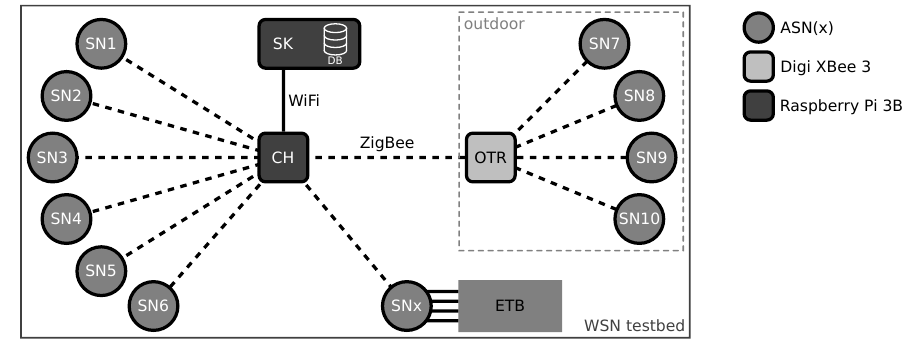
Figure 10. Architecture of the experiment setup (WSN testbed).